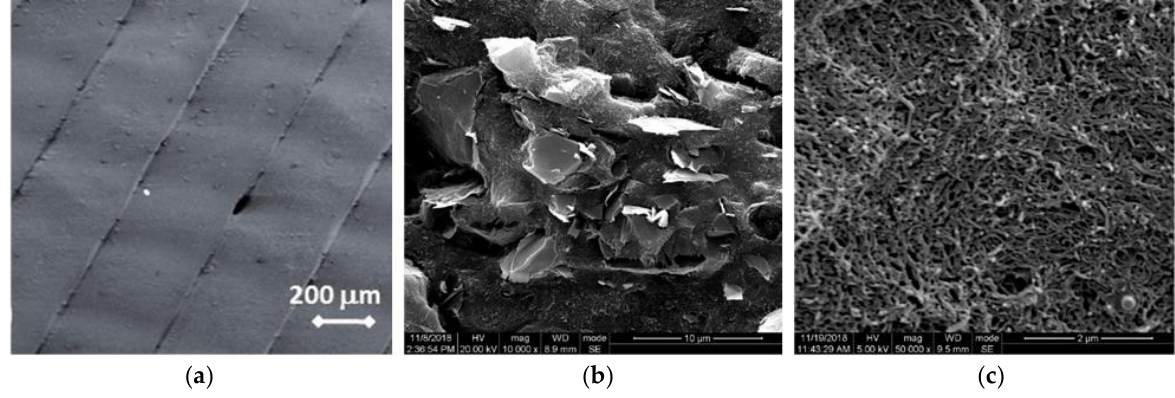
Figure 1. SEM micrographs of: ( a ) the surface of 3D printed GNP/PLA, ( b ) cross-section of GNP/PLA, and ( c) cross-section of MWCNT/PLA at 9 wt.% filler content.